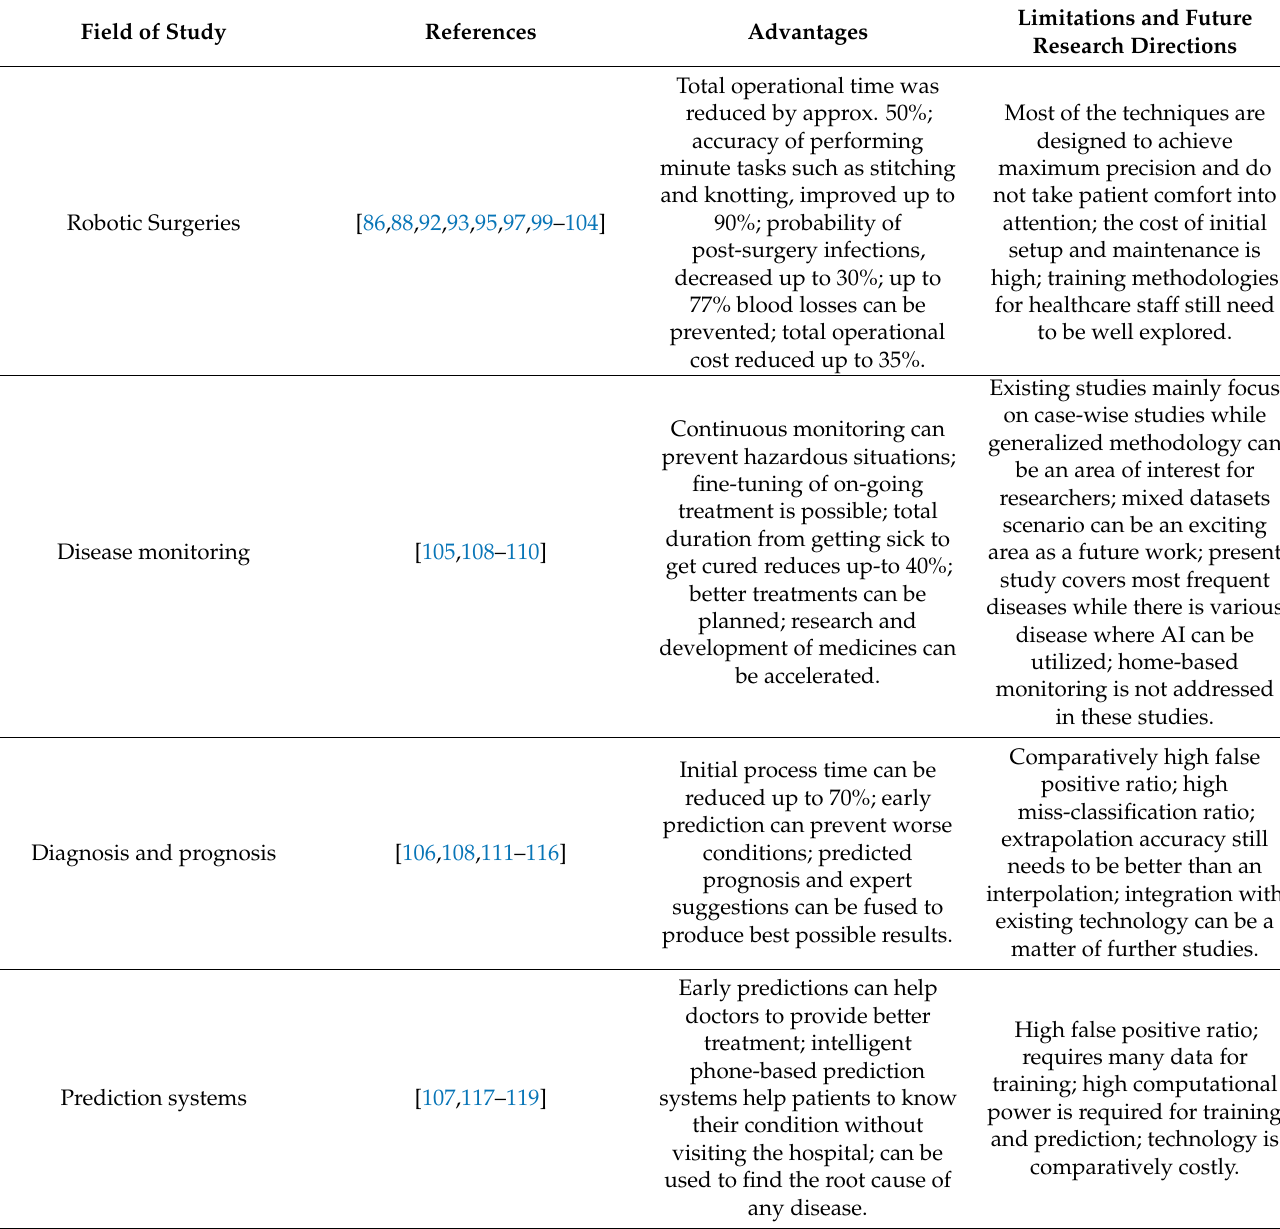
Table 4. Advantages and limitations of existing studies employing Artificial Intelligence and Machine Learning in